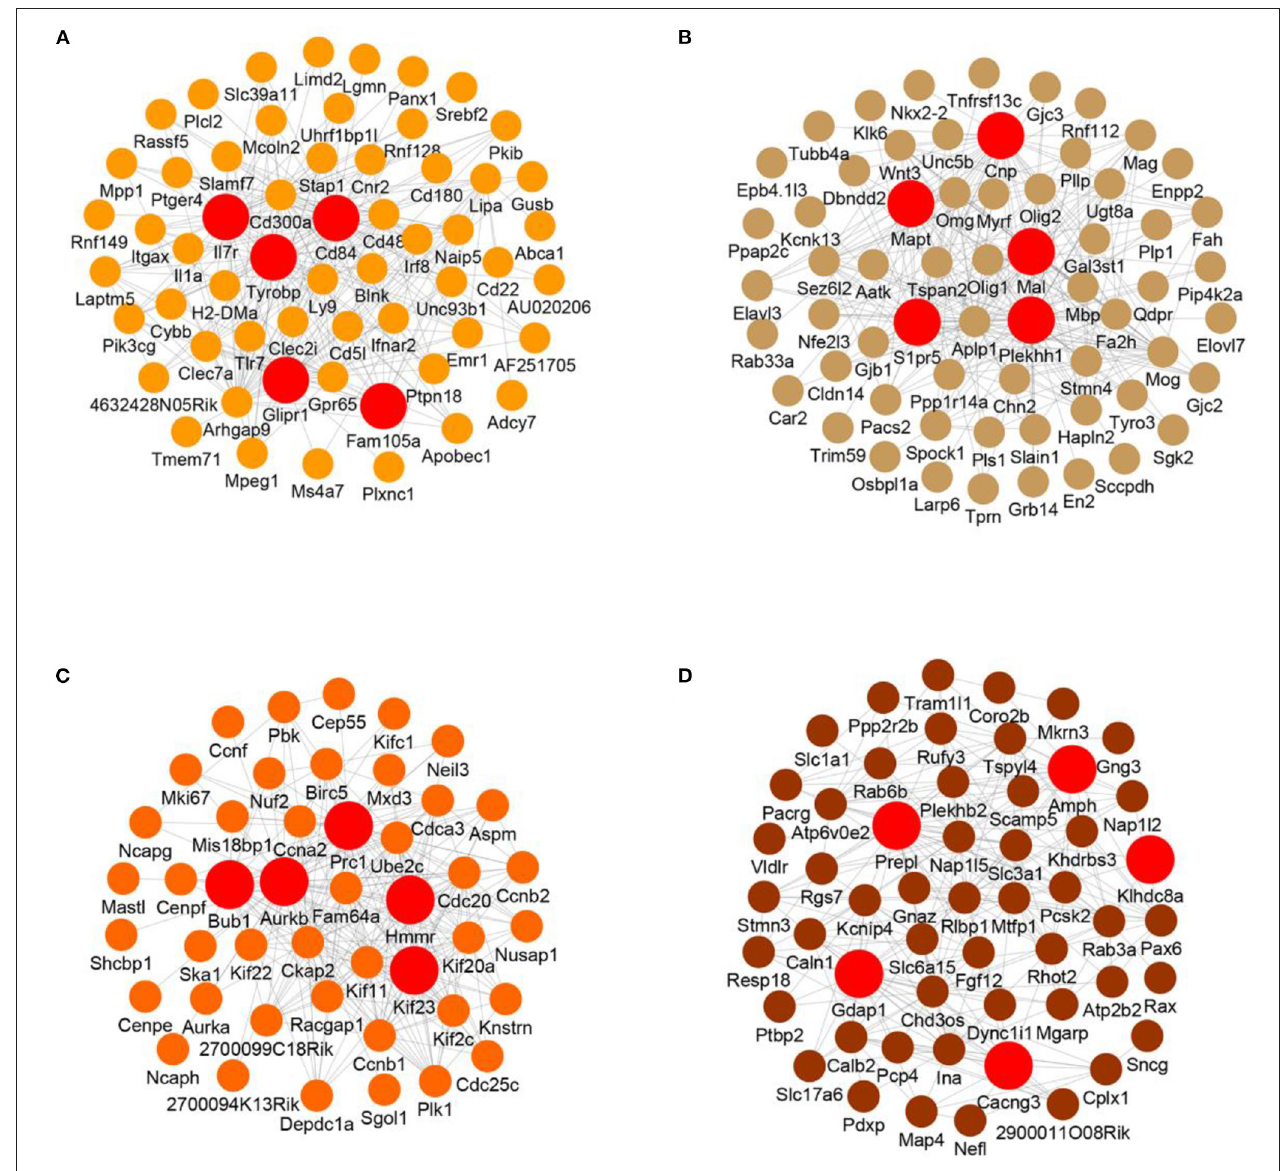
FIGURE 5 | Visualized network of each module. (A–D) Visualized networks based on the top 250 gene connections of the M2 (A) , M4 (B) , M5 (C) , and M6 (D) modules. The top 5 hub genes based on degree in each module are shown.